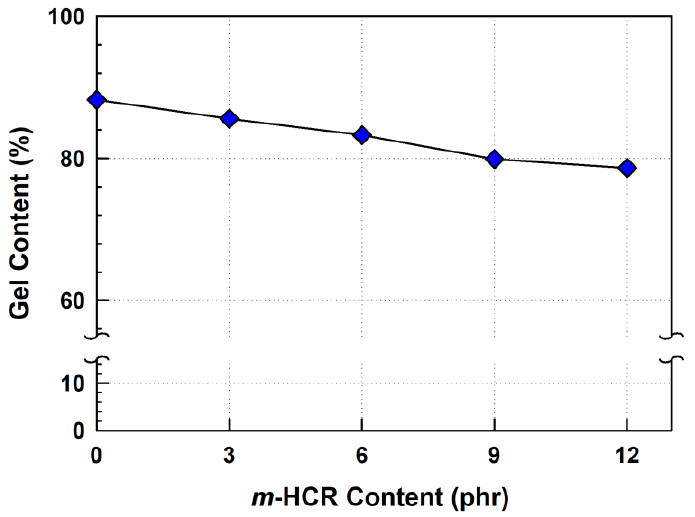
Figure 3. Gel content for the crosslinked neat POE and POE blends with m -HCR.